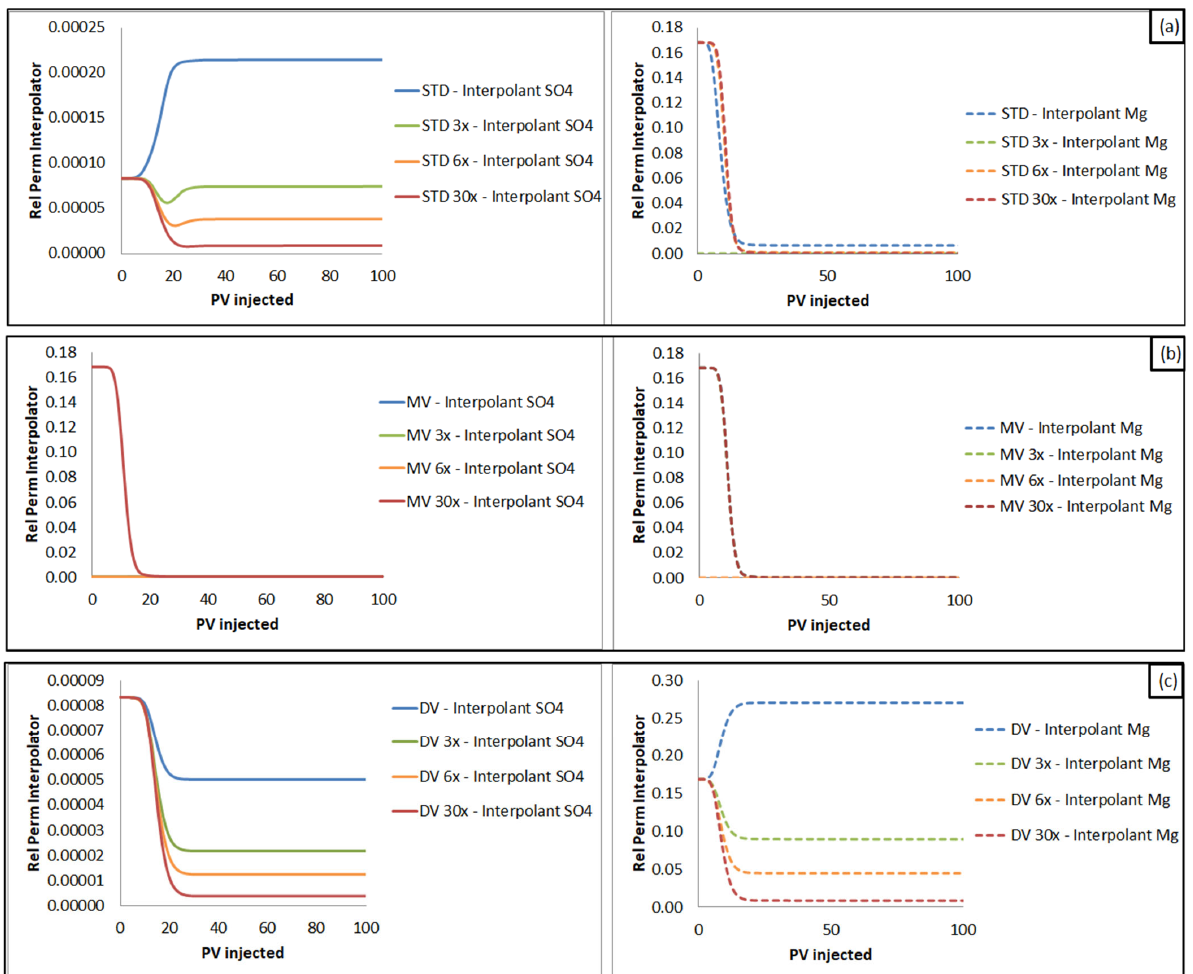
Figure 7. Interpolation factor variation of the relative permeability curves in the grid block {30,1,1} for brine injection: ( a ) STD; ( b ) MV and ( c ) DV.